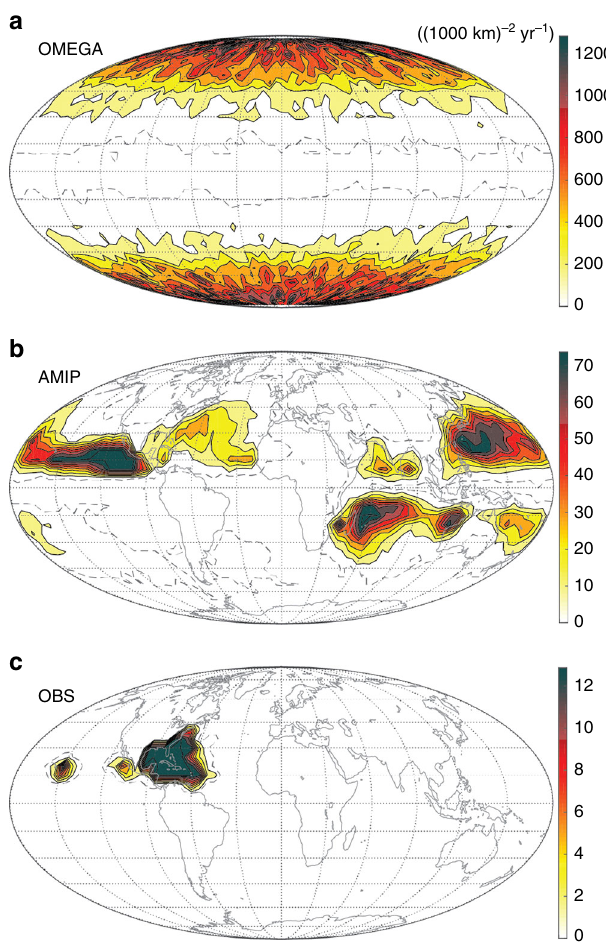
Fig. 1 Storm count density across simulations and observations. a OMEGA. b AMIP. c Observations. Density is de fi ned as number of track points per (1000 km) 2 per year, calculated from data binned into lat-lon boxes of side length 5° weighted by the cosine of the box central latitude. Maximum value set to 99th percentile for clarity; gray dashed line denotes zero density contour. No data fi lters are